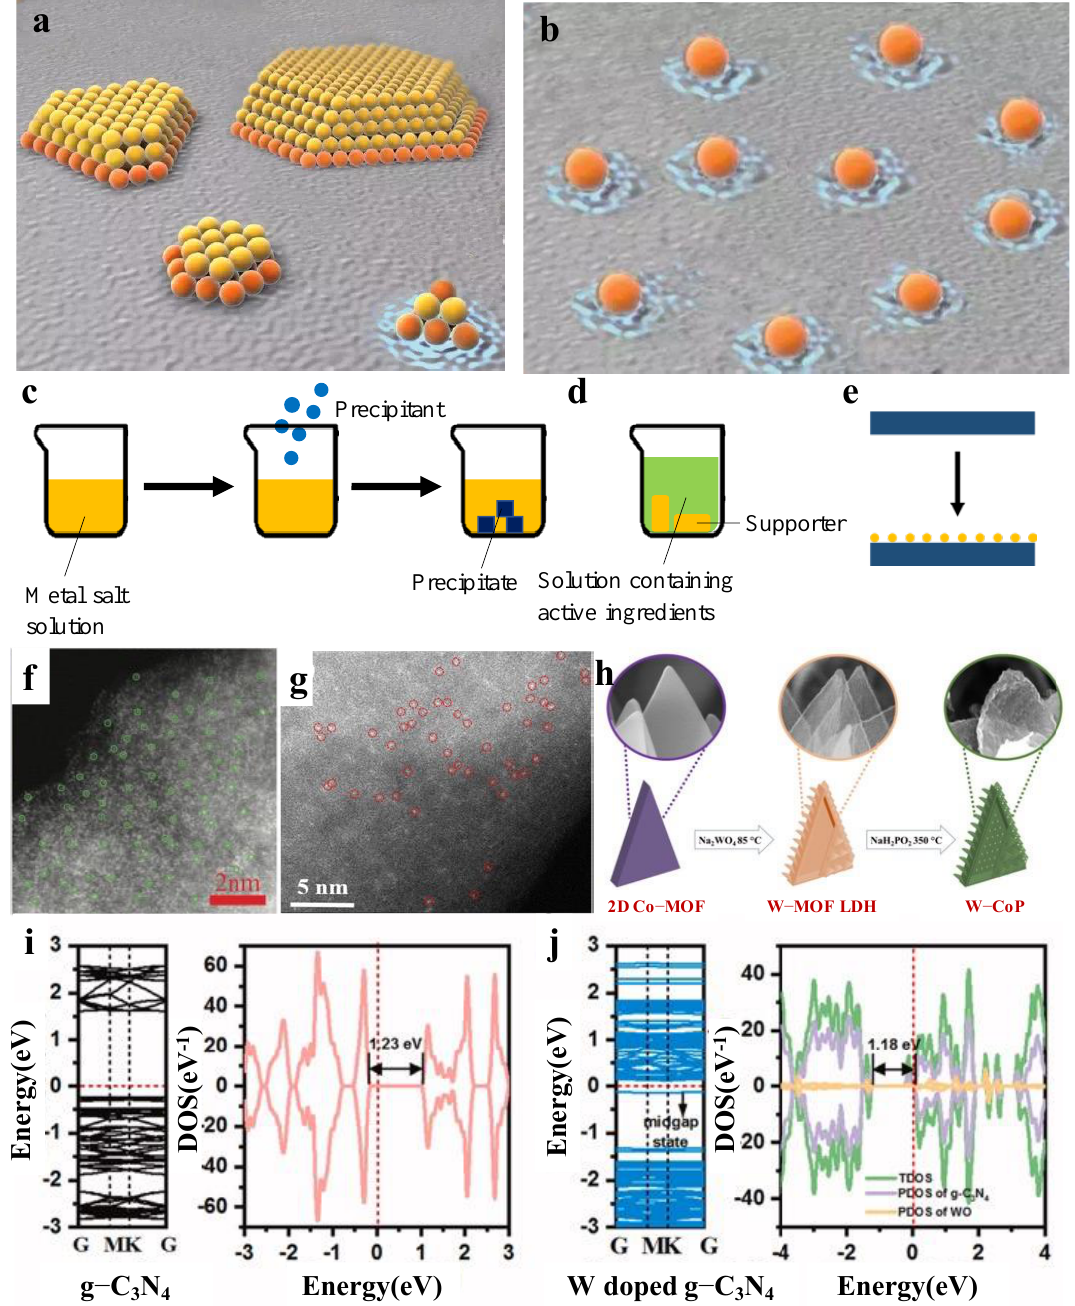
Figure 5. ( a ) Structural diagram of nanocatalysts. ( b ) Structural diagram of SACs. Diagram of the preparation method: ( c ) coprecipitation; ( d ) immersion; ( e ) atomic layer deposition. ( f ) Illustration of the formation of W-SAC. ( g ) HAADF-STEM image of the W-SAC. ( h ) HAADF-STEM image of the W-N-C catalysts. Band structures, total and projected density of states for ( i ) pure g-C 3 N 4 and ( j ) W-doped g-C 3 N 4 .